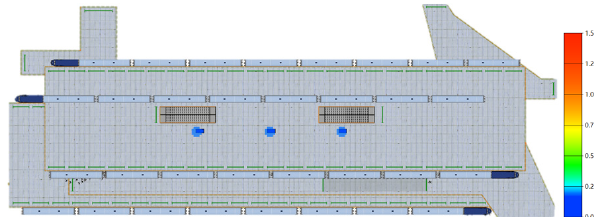
Figure 9. Pedestrian distribution density at 10 s.